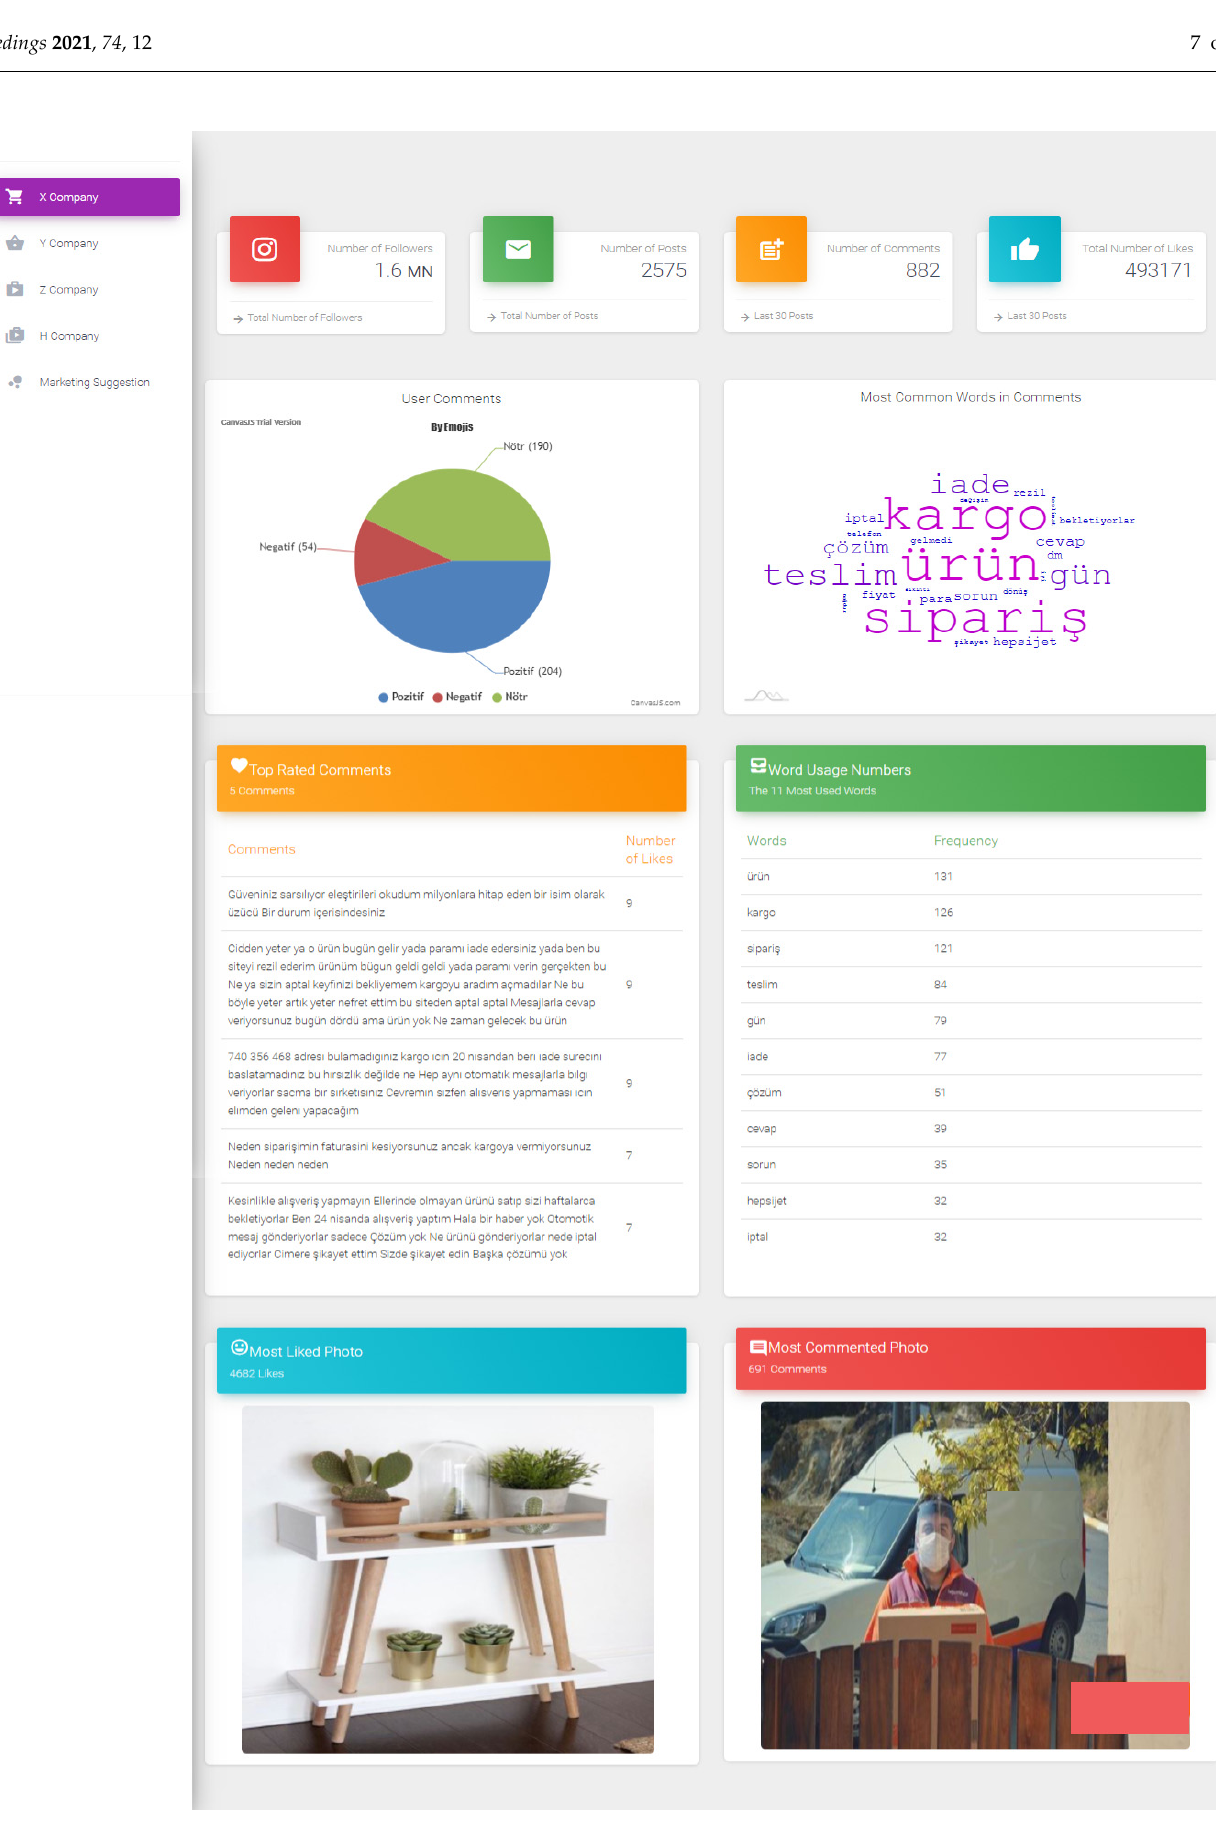
Figure 4. Application interface for X